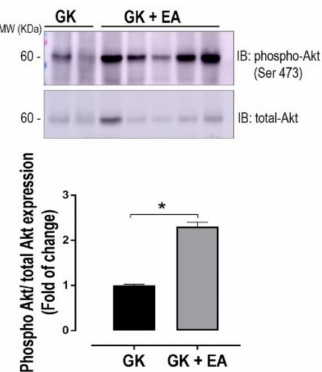
Figure 6. EA treatment ameliorates hepatic insulin signaling. Expression of phosphorylated Akt at serine 473 in hepatic homogenate from diabetic GK rats with or without treatment with EA (50 mg/kg) for 45 days. Top panel: representative blot. Bottom panel: densitometry analysis. Data are presented as mean ± SEM; * p < 0.05, ( n = 6 per